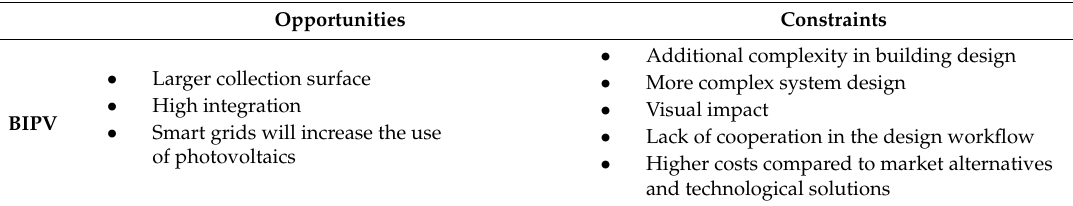
Table 10. Compare BIPV and hBESST and related opportunities and